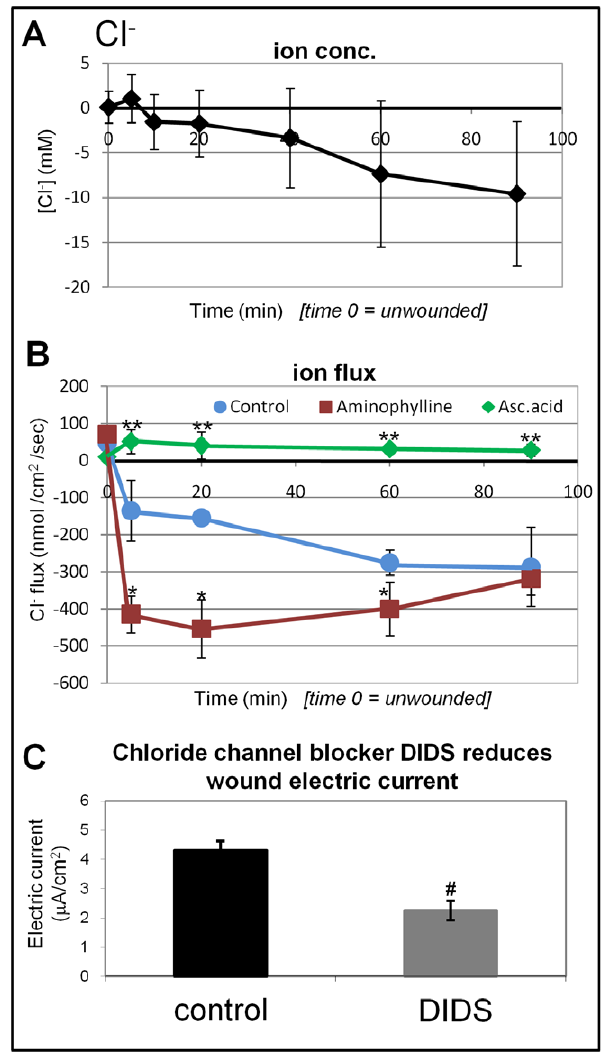
Figure 6. Chloride flux at corneal wounds A. Cl 2 concentration. Unwounded cornea had a slighly higher Cl 2 concentration than background. Upon wounding, the Cl 2 concentration at the wound edge transiently increased, (5 min) and then decreased, becoming lower than background (negative values) from 10 min onwards. B. Cl 2 flux. Unwounded cornea had a small chloride efflux. Wounding induced a large, sustained influx which increased with time. Ascorbic acid reversed the chloride influx, giving a small efflux (**P , 0.01), but aminophylline significantly enhanced chloride influx at time-points 5– 60 min (*P , 0.04). C. Wound electric current was significantly reduced in the presence of 200 m M broad-spectrum chloride channel blocker DIDS ( # P ,